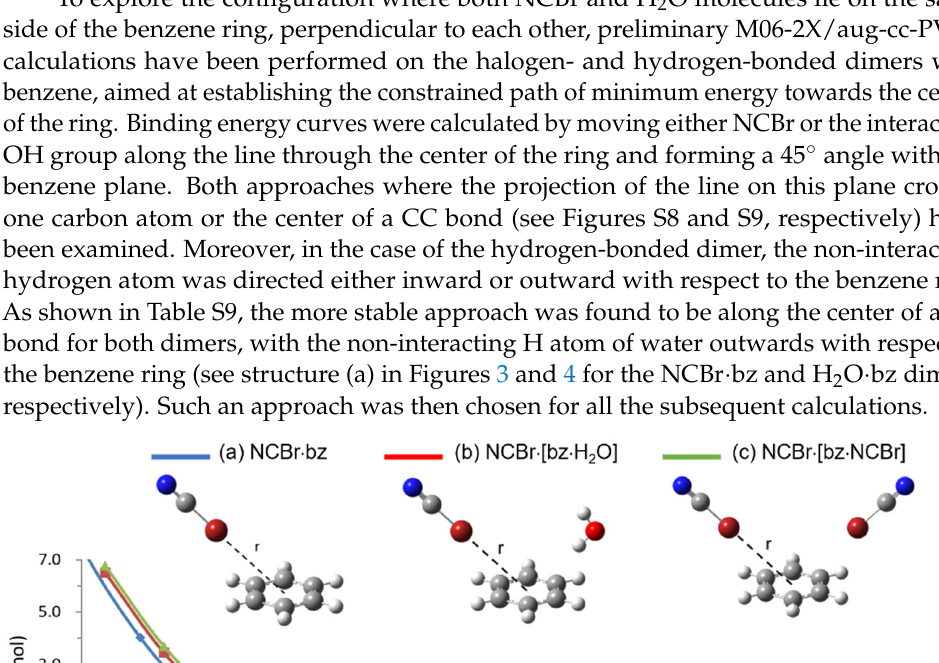
Figure 4. Binding energy curves, Δ E, vs. (HO)H distance from the center of benzene ring, r, com- puted for ( a ) H 2 O·bz (blue line), ( b ) H 2 O·[bz·NCBr] (red line), and ( c ) H 2 O·[bz·H 2 O] (green line) systems in the perpendicular approach at the M06-2X/aug-cc-PVTZ level of theory. Compared with the results obtained on dimers in T-shaped configuration, the higher interaction energies are obtained with the ω B97X functional, while M11 still provides the lower Δ E values (see Table 2). Moreover, the examined functionals provide much more different interaction energies despite rather similar equilibrium distances. The variations from the ω B97X values to the M11 ones amount to 0.68 ( Δ E XB ) and 0.61 ( Δ E HB ) kcal/mol, corresponding to 27.5 and 23.5% reductions with respect to the higher ω B97X values. Such discrepancies are much higher than those (9.1 and 12.2%) determined for the T-shape ap- proach. Considering that, in the two different approaches, we are dealing with the same molecules in different orientations, it may be hypothesized that the larger discrepancies observed for the bent dimers could be ascribed to the fact that this orientation is more outside, with respect to the T-shaped configuration, the minimum energy one, implying a stronger angular dependent energy bias [50]. Table 2. Equilibrium distances r eq (Å) and interaction energies Δ E XB and Δ E HB (kcal/mol) for dimers and trimers in perpendicular configuration. Functional NCBr · bz NCBr · [bz · H 2 O] NCBr · [bz · NCBr] r eq Δ E XB r eq Δ E XB